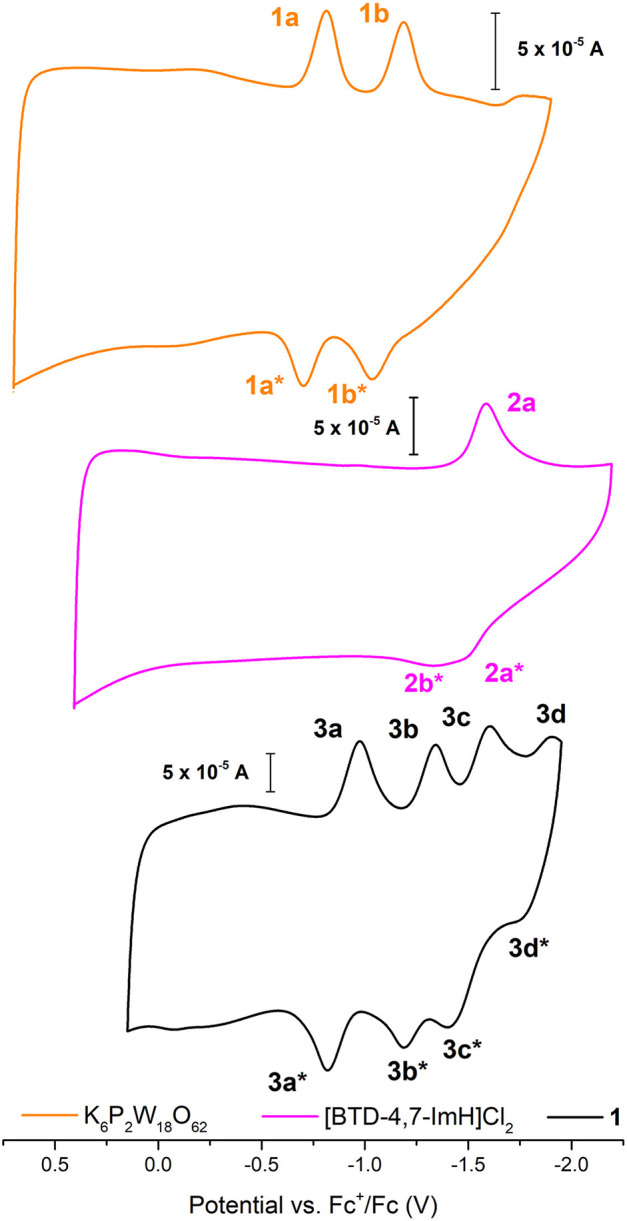
Solid-state cyclic voltammetry of 1 K6P2W18O62 (orange), [BTD-4,7-ImH]Cl2 (pink), and 1 (black) performed in anhydrous acetonitrile (10 ml) with 0.1 M of TBAPF6 as supporting electrolyte and reported vs. Fc+/Fc as an internal reference.